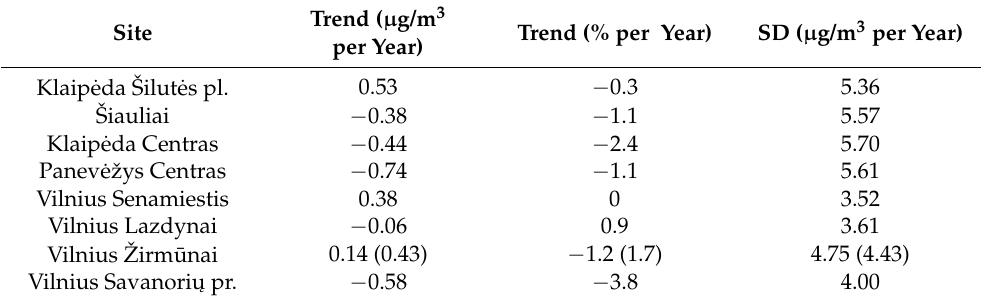
Table 4. The overall values of the annual PM 10 (PM 2.5 ) trend were observed along standard deviation (SD).